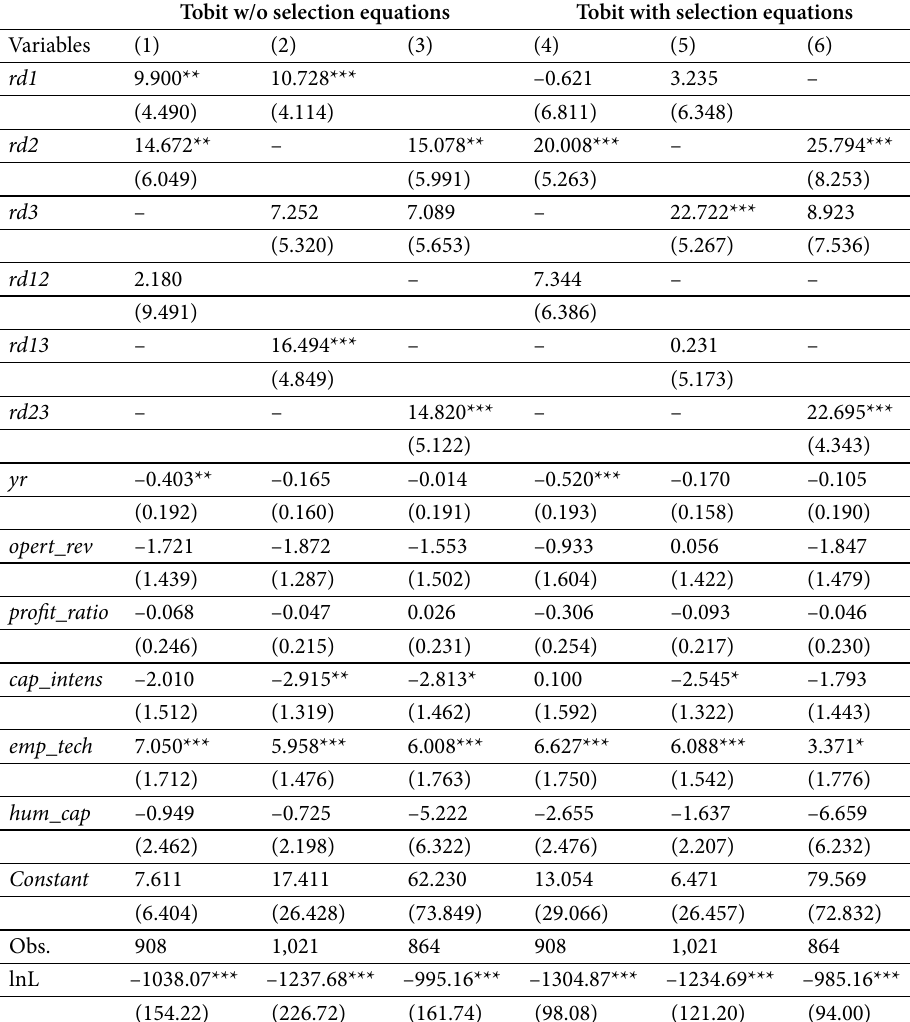
Table 4. Estimation results of innovation output (measured by sales share of